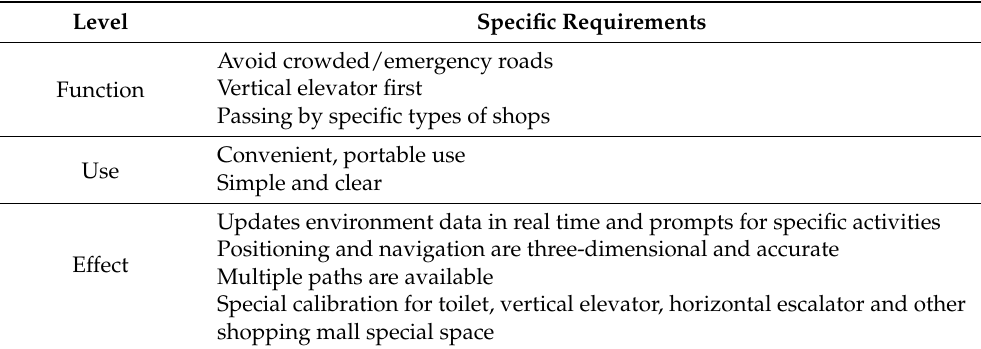
Table 14. Classification and design of shopping mall interior navigation